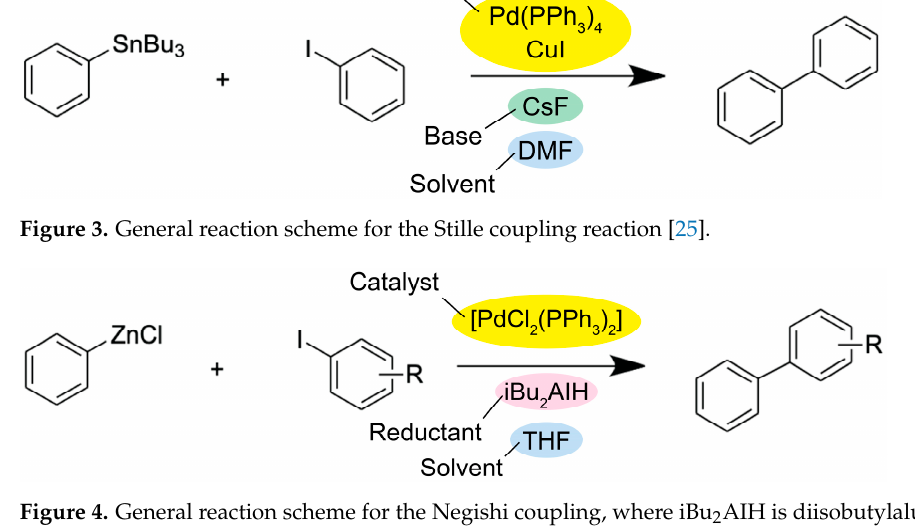
Figure 4. General reaction scheme for the Negishi coupling, where iBu 2 AIH is diisobutylaluminium hydride [23].